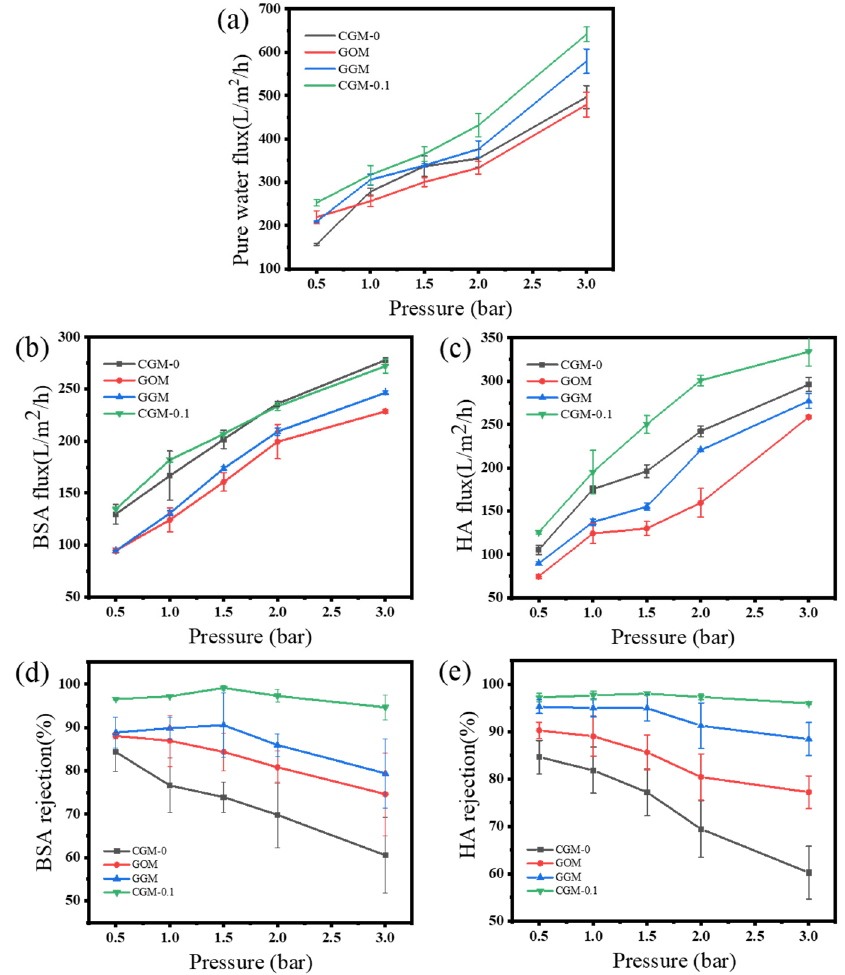
Figure 10. Pure water flux ( a ), BSA flux ( b ), HA flux ( c ), BSA rejection ( d ), and HA retention ( e ) for CGM-0, GOM, GGM and CGM-0.1 at different operating pressures.